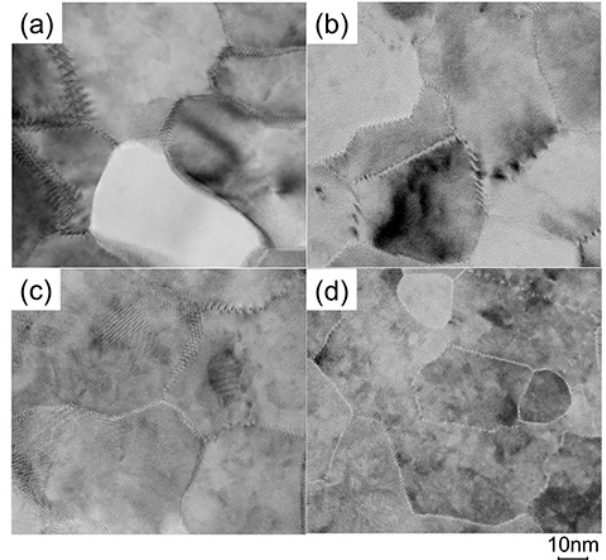
Figure 11. Plan-view TEM images of the as-deposited films of ( a ) ZnO:Al (0.25 wt %) and ( b ) ZnO:Al (2.0 wt %); and post-annealed films of ( c ) ZnO:Al (0.25 wt %) and ( d ) ZnO:Al (2.0 wt %) films at 650 °C at a P O2 of 1 × 10 − 23 atm.